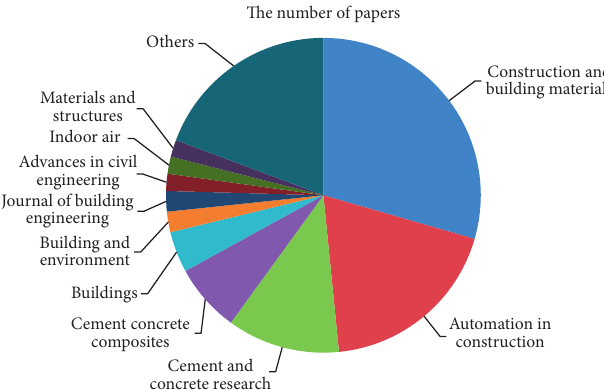
Figure 3: Source journals conforming with the statistics of the WOS core collection